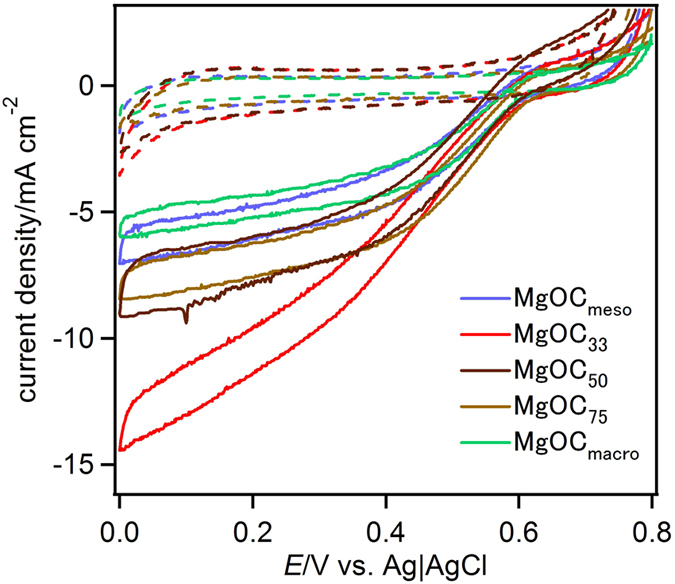
CV data for BOD adsorbed on a MgOC-modified electrode in a citrate buffer (0.1 M, pH 5.0) under O2-saturated conditions at 25 °C (solid curve).MgOCmeso (blue), MgOC33 (red), MgOC50 (blue), MgOC75 (purple), MgOCmacro (green). The scan rate was 1 mV s−1. Dashed curves indicate CVs without BOD.